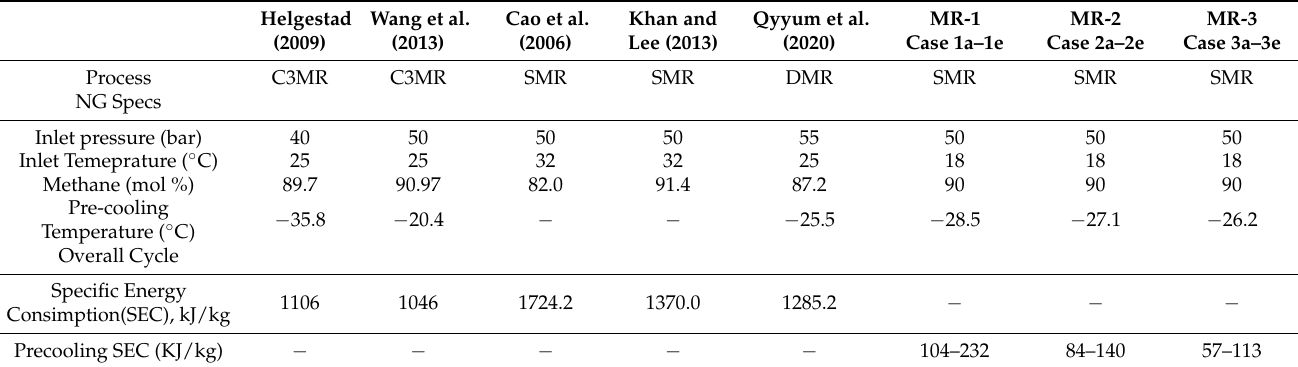
Table 8. Results obtained from